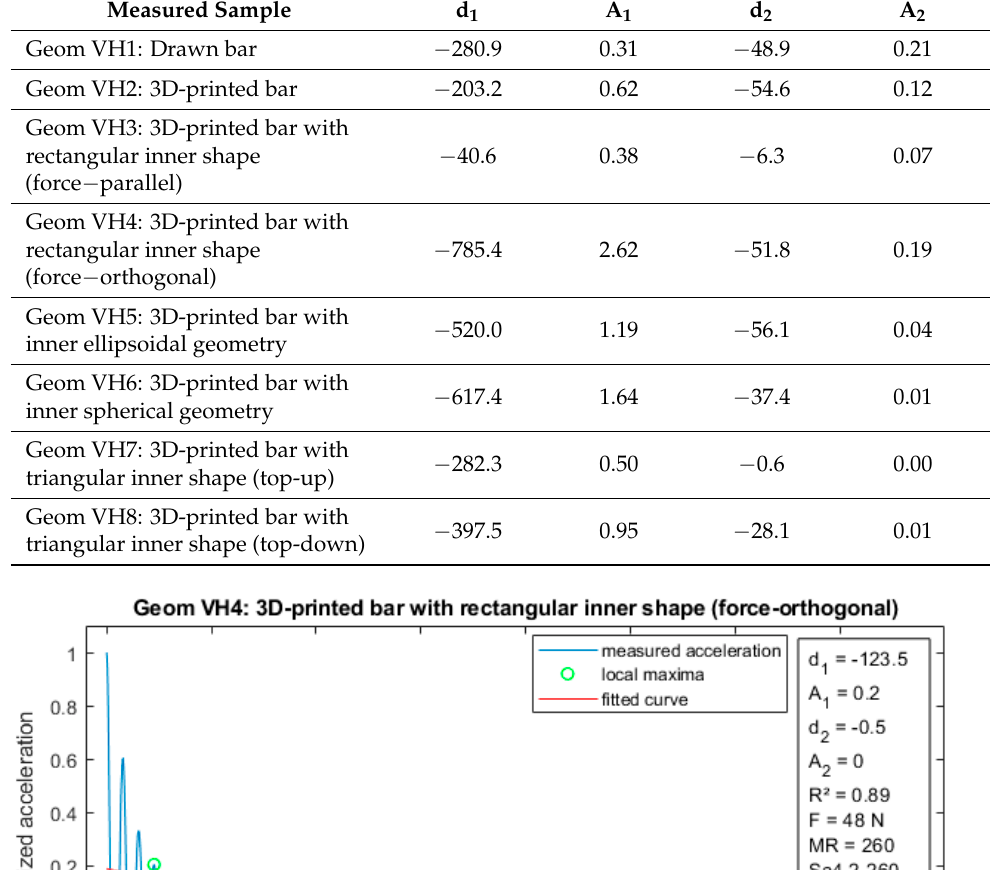
Table 1. Overview of the parameters for function â damp .